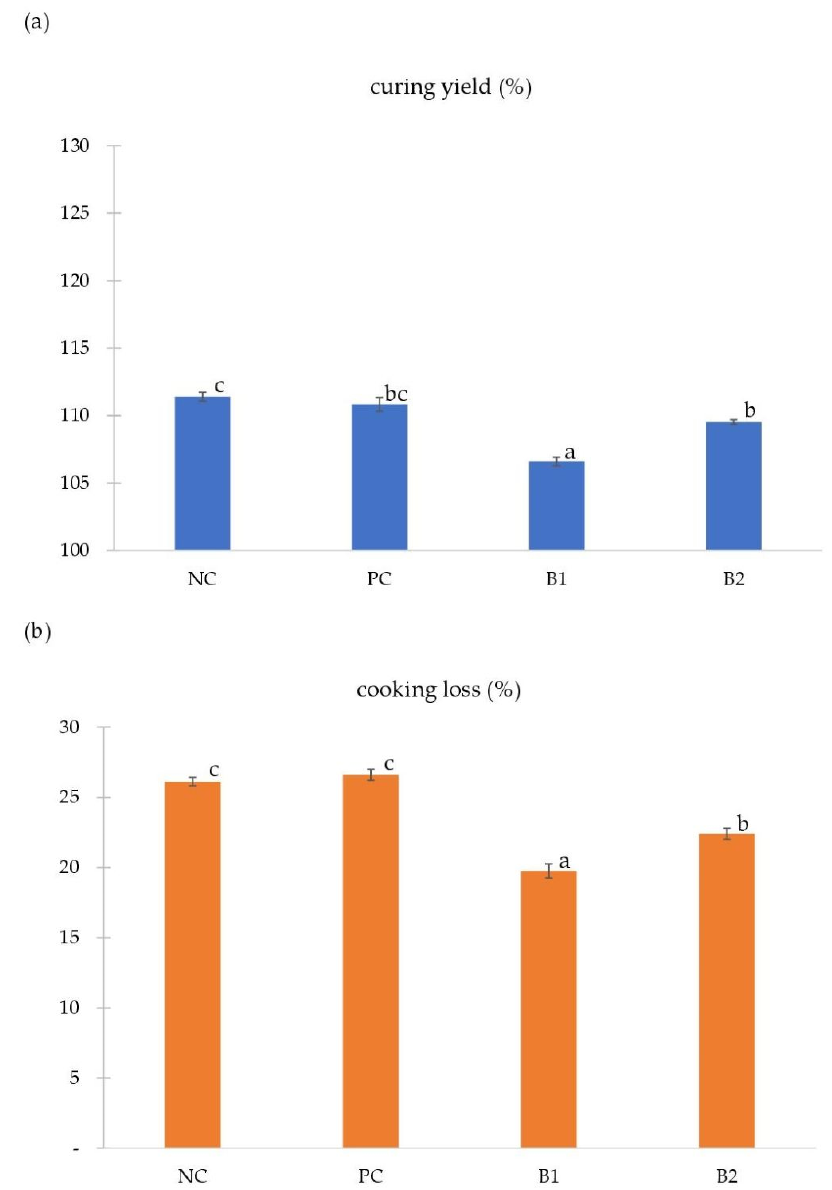
Figure 2. The effect of alternative nitrite sources on curing yield ( a ) and cooking loss ( b ) of cured pork loins (mean ± SE); NC—negative control (pork loins soaked in nitrite-free brine); PC—positive control (pork loins soaked in brine containing sodium nitrite); B1—pork loins soaked in brine containing plasma-activated powder of cow milk; B2—pork loins soaked in brine containing plasma-activated powder of soy milk; a–c—the mean values with different letters differ statistically significantly ( p < 0.05).